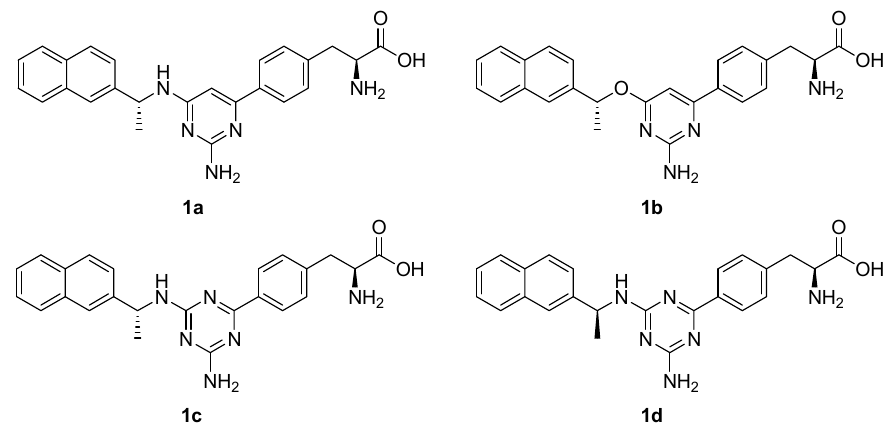
Figure 1. The chemical structures of the phenylalanine derivative inhibitors of TPH1.